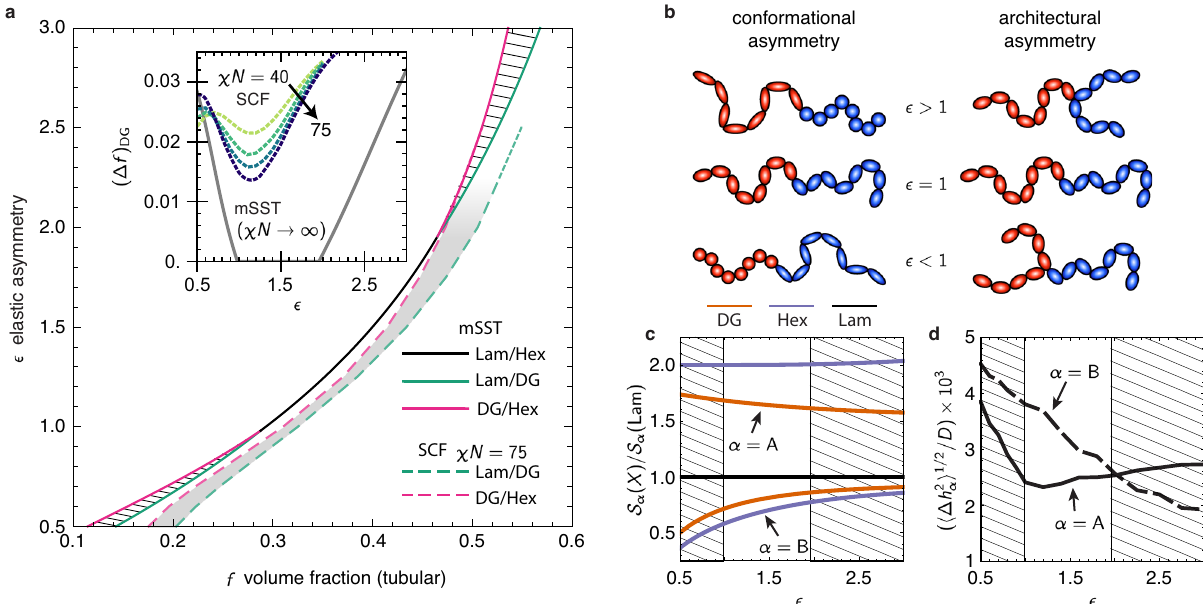
Fig. 4 Effects of elastic asymmetry on double-gyroid stability. a Shows the stability of DG, Hex and Lam in the f - ϵ plane for medial SST (mSST), with hatched regions indicating stable DG windows. Dashed curves indicate corresponding boundaries for the SCF at χ N = 75, and the inset compares the composition width of the DG stability region ( Δ f ) DG between in fi nite- and fi nite-segregation theories, including results for χ N = 40, 50, and 60. b Schematic illustration of the dependence of elastic asymmetry on conformational (segment length) asymmetry and architectural (branch) asymmetry for AB miktoarm copolymers. c compares the block stretching costs between the competitor morphologies along the F (Lam) = F (Hex) line for variable elastic asymmetry, while ( d ) compares the variance in domain thickness in DG domains along the same line. In both, the hatched regions shown predicted DG